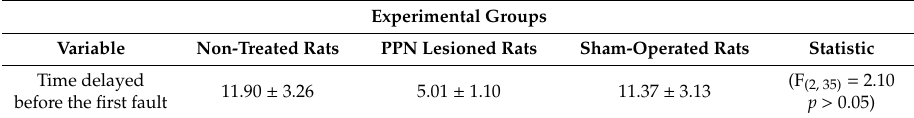
Table 1. Comparison of the time delayed for the rats before the first fault during the execution of Grid Test seven days after pedunculopontine nucleus lesion. One-way ANOVA test. The data represent x ± E.E.M.